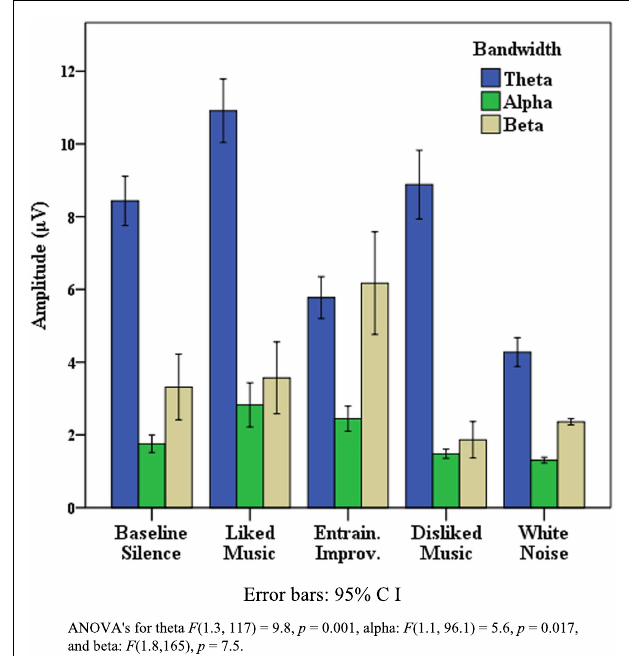
FIGURE 8 | Case “C”: EEG global responses across bandwidths .